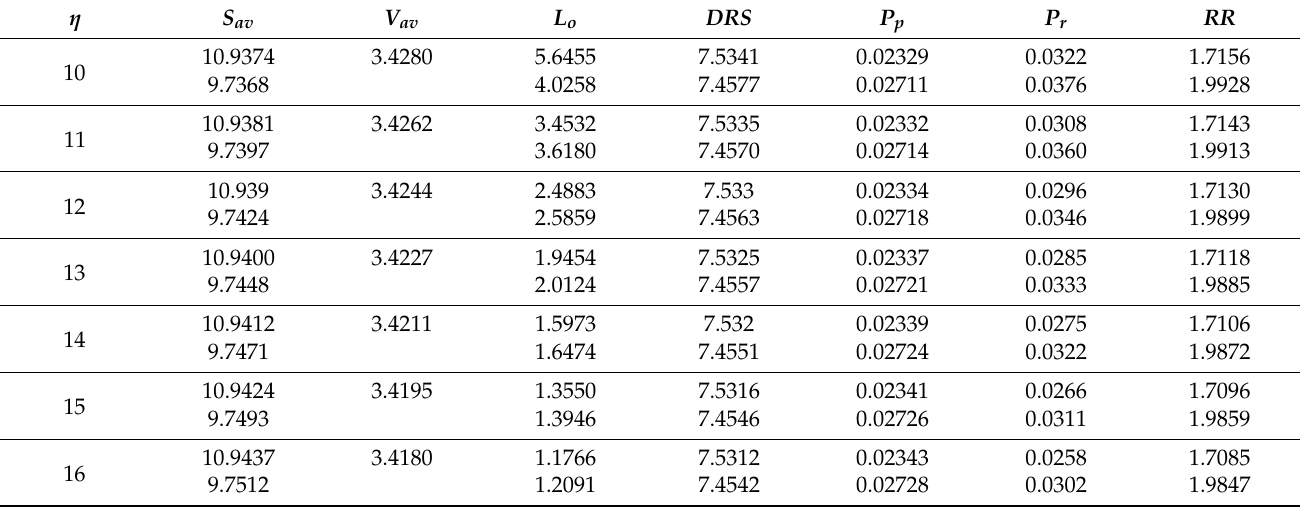
Table 2. Dependence of the performance measures on parameter η ; λ = 20, κ = 8, ν = 10, α = 0.4, and β = γ = 0.6.